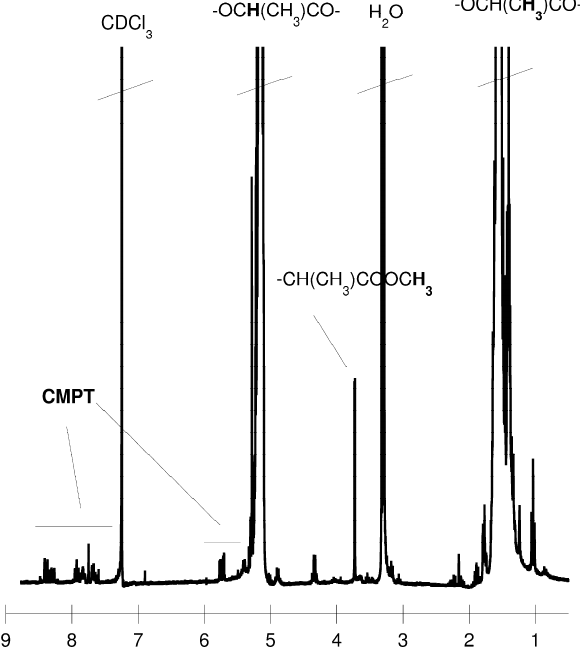
Figure 1. 1 H-NMR spectrum of the CMPT-PLA